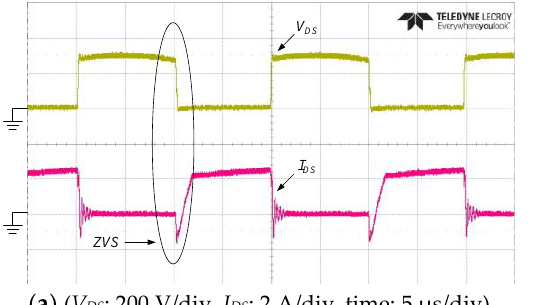
Figure 21. Measured switch voltage V DS and current I DS of the proposed hybrid converter operated in the utility line condition under 100% of the full-load condition: ( a ) switch M 1 and ( b ) switch M 2 .